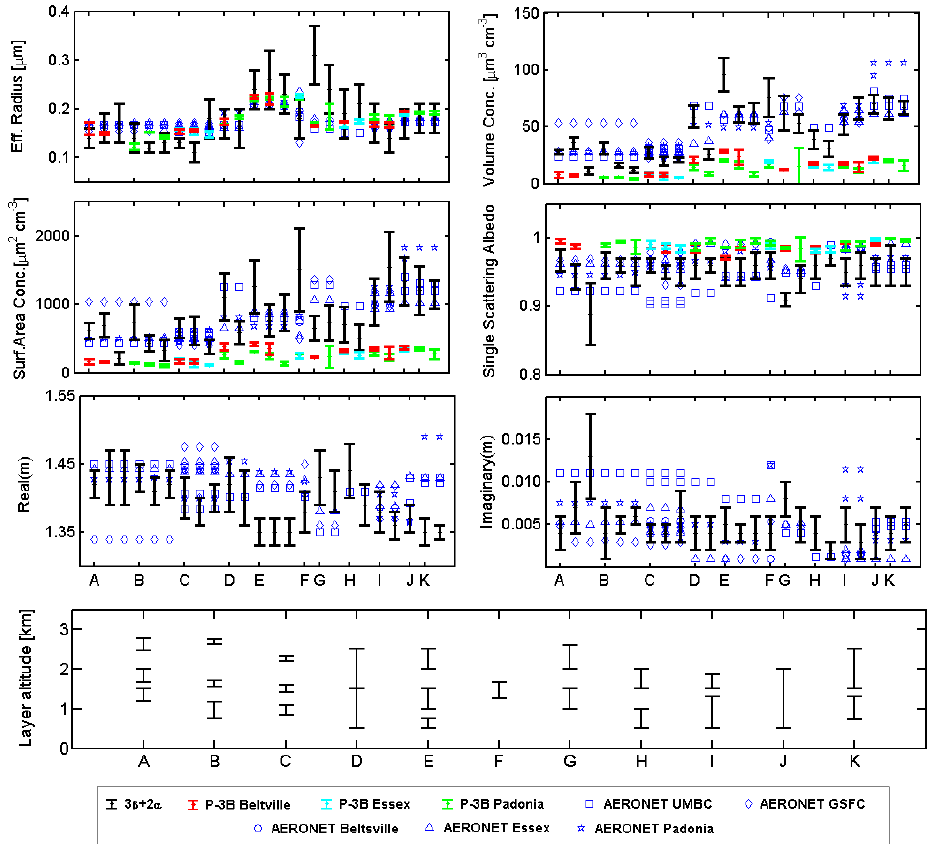
Figure 6. Results of effective radius, volume and surface-area concentrations, single-scattering albedo, and complex index of refraction obtained from inversion of the hybrid multiwavelength lidar data set (3 β + 2 α ), from AERONET inversions, and from in situ measurements obtained by the P-3B aircraft (under dry